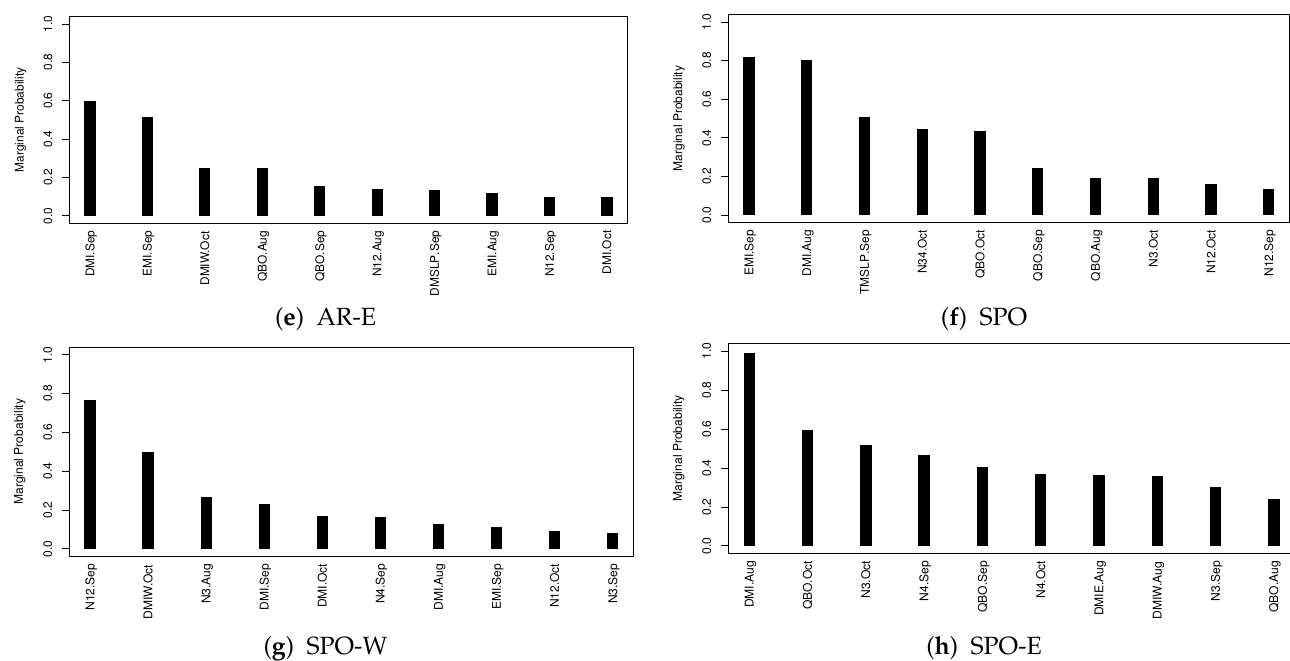
Figure 4. The marginal probabilities for top ten predictors in each region.